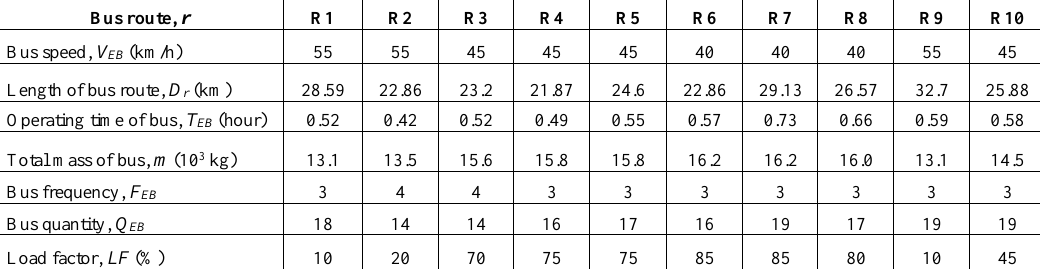
Table 2. Data input to quantify energy consumption [47, 48].